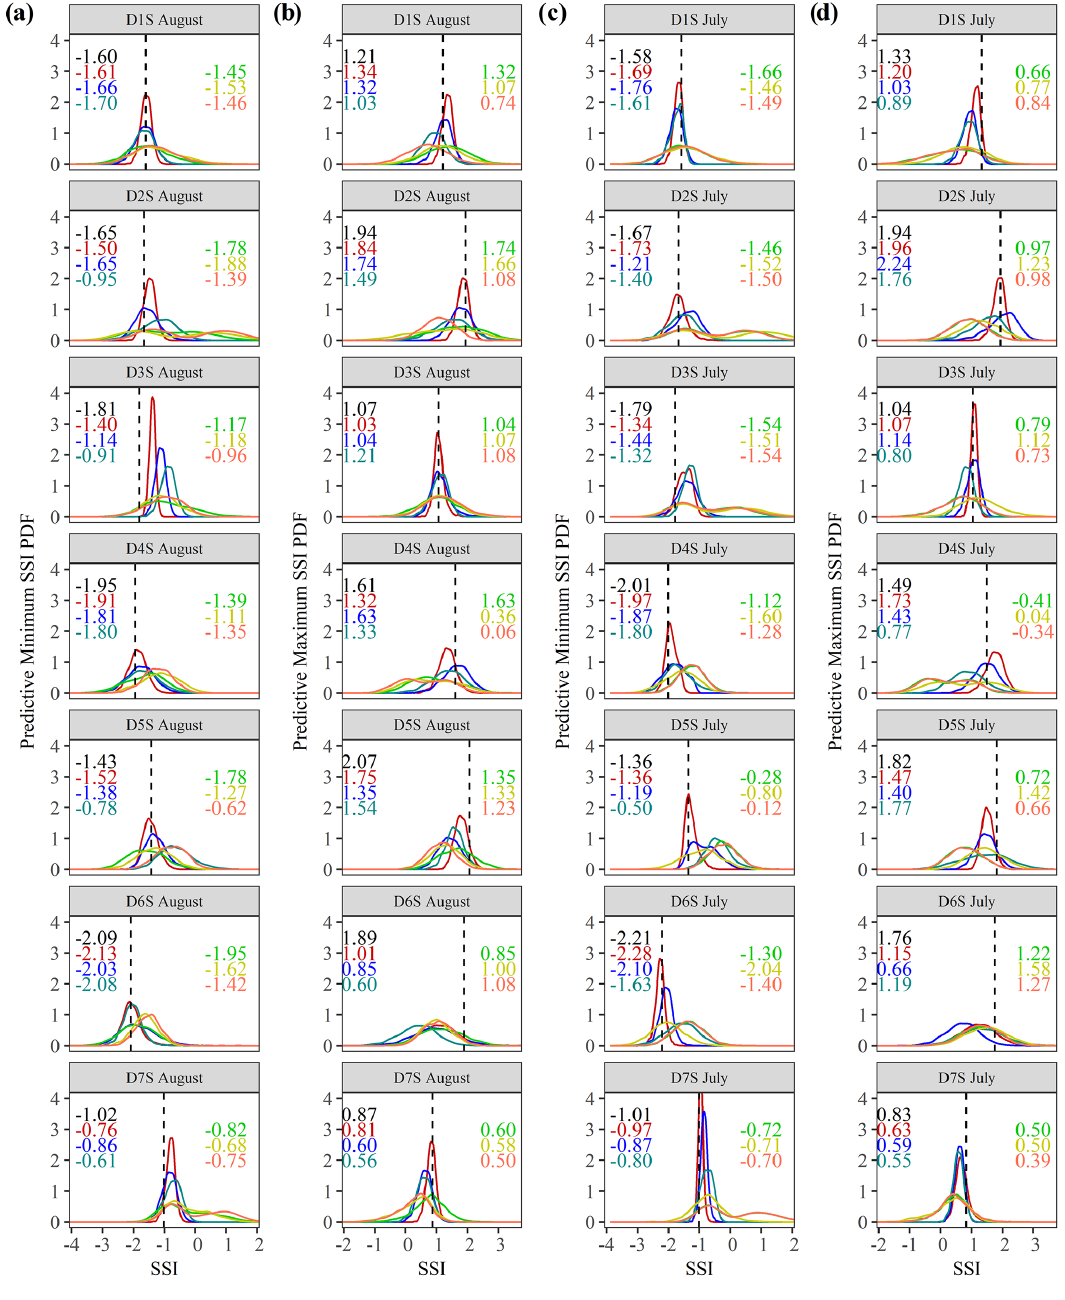
Figure 7. Probability density function (PDF) curve of minimum (a, c) and maximum (b, d) SSI for 1- to 3-month lead times for August (a, b) and July (c, d) during the 1961–2018 period over seven selected typical areas in the climate regions D1–D7 (i.e., the black rectangles in Fig. 6b signify regions D1S–D7S; see labels). The black dashed line and text indicate the minimum and maximum SSI observations in August and July over D1S–D7S. The red (green), blue (yellow), and cyan (coral) text on the left (right) of each subfigure denote SSI forecasts for 1- to 3-month lead times in August or July from the 3C-vine model (MG model), which correspond to the abscissa projected by the peak point of each